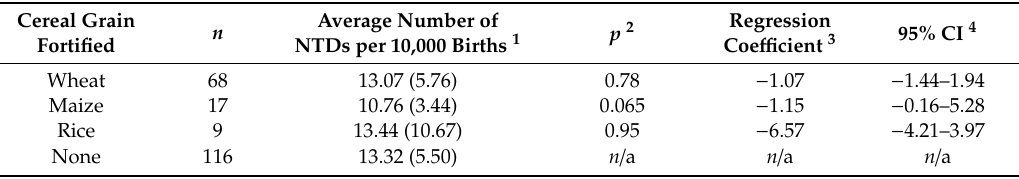
Table 2. Prevalence of neural tube defects (NTDs) as a function of folic acid